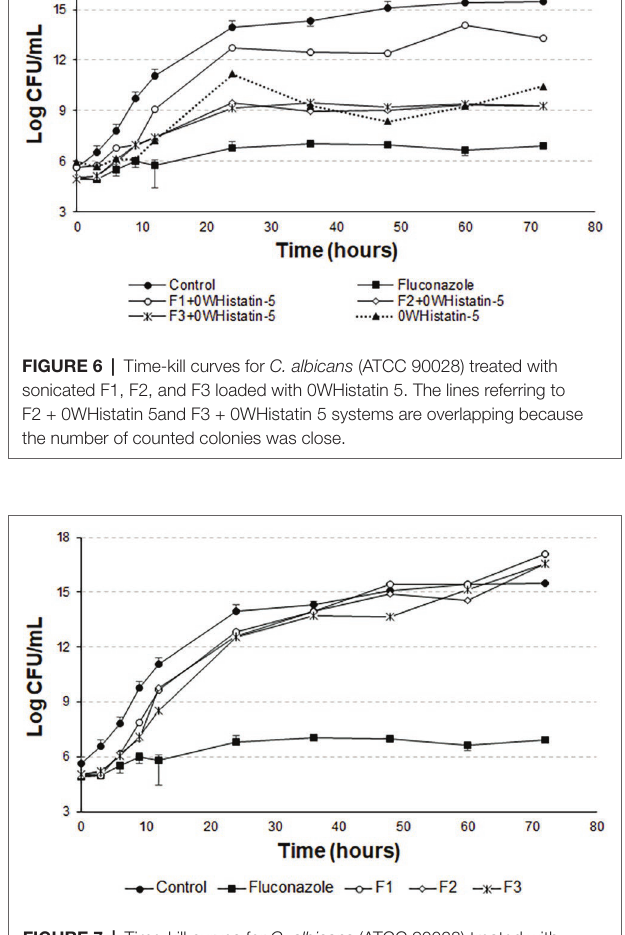
FIGURE 8 | Time-kill curves for C. albicans (ATCC 90028) treated with extruded and empty F1, F2, and F3.